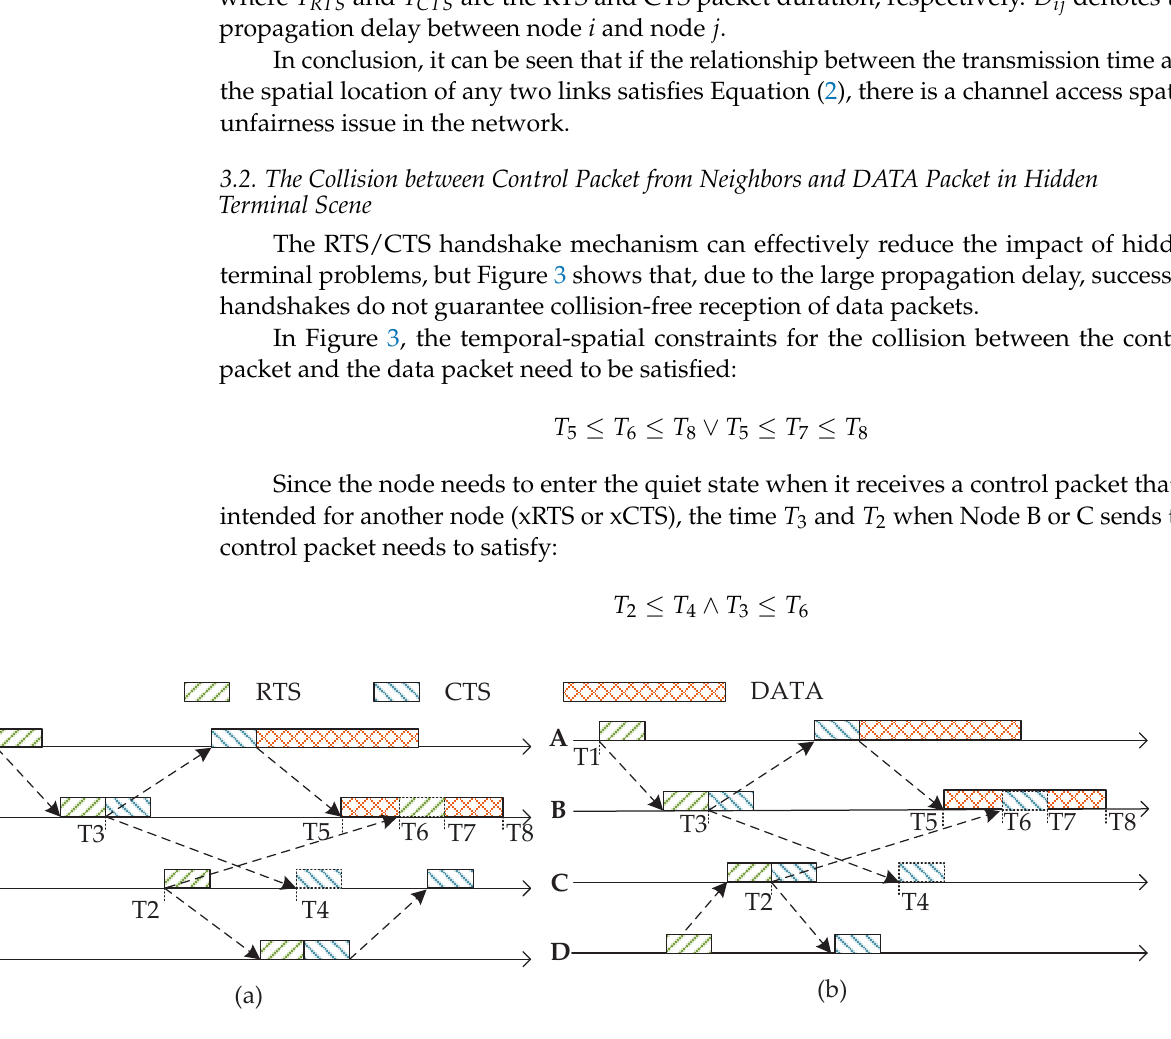
Figure 3. Collision between control packet from neighbors and data packet in hidden terminal scene. ( a ) The hidden transmit terminal. ( b ) The hidden receive